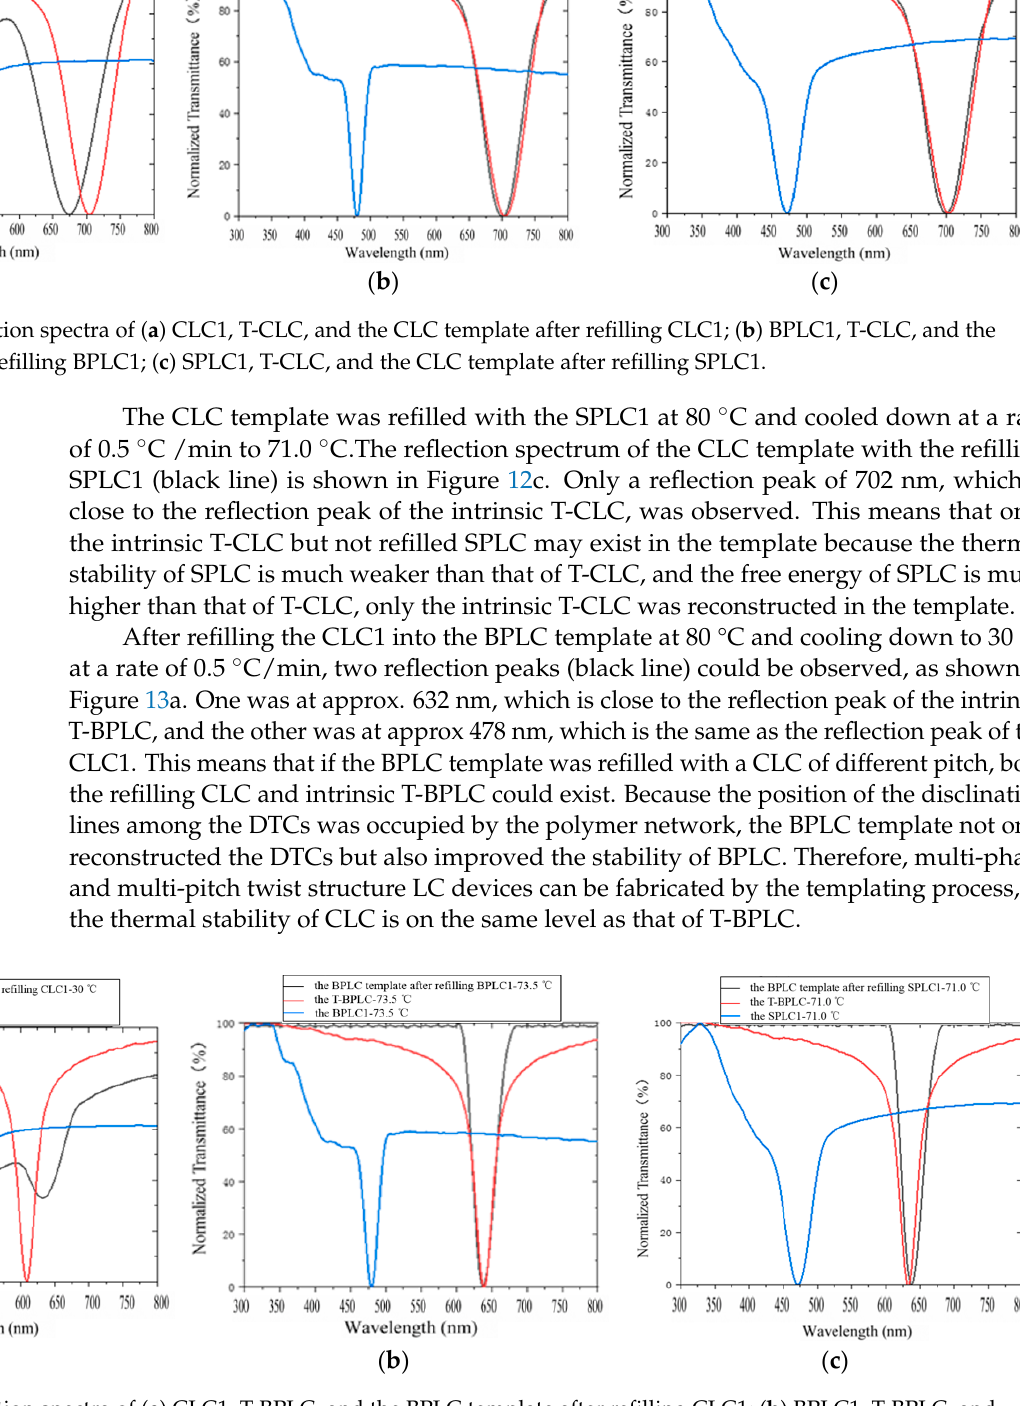
Figure 13. The reflection spectra of ( a ) CLC1, T-BPLC, and the BPLC template after refilling CLC1; ( b ) BPLC1, T-BPLC, and the BPLC template after refilling BPLC1; ( c ) SPLC1, T-BPLC, and the BPLC template after refilling SPLC1. The BPLC template was refilled with the BPLC1 at 80 °C and cooled down at a rate of 0.5 °C /min to 73.5 °C . The reflection spectrum of the BPLC template with the refilling BPLC1 (black line) is shown in Figure 13b. Only a reflection peak of 638 nm, which is the same as the reflection peak of the intrinsic T-BPLC, was observed. This means that only the intrinsic T-BPLC but not refilled BPLC may exist in the template because the thermal stability of BPLC is much weaker than that of T-BPLC, and the free energy of BPLC is much higher than that of T-BPLC; hence, only the intrinsic T-BPLC was reconstructed in the template. The BPLC template was refilled with the SPLC1 at 80 °C and cooled down at a rate of 0.5 °C/min to 71.0 °C. The reflection spectrum of the BPLC template with the refilling SPLC1 (black line) is shown in Figure 13 c . Only a reflection peak of 638 nm, which is close to the reflection peak of the intrinsic T-BPLC, was observed. This means that only the intrinsic T-BPLC but not refilled SPLC may exist in the template because the thermal stability of SPLC is much weaker than that of T-BPLC, and the free energy of SPLC is much higher than that of T-BPLC; hence, only the intrinsic T-BPLC was reconstructed in the template. After refilling the CLC2 into the SPLC template at 80 ℃ , and cooling down to 30 °C at a rate of 0.5 °C/min, the reflection spectrum of SPLC template with the refilling CLC2 (black line) was obtained, as shown in Figure 14a. Only a reflection peak of 470 nm was observed, which is close to the reflection peak of the intrinsic T-SPLC. This means that only the intrinsic T-SPLC but not refilled CLC may exist in the template. However, when the CLC2 was directly refilled into the SPLC template at 30 °C, two reflection peaks (black line) could be observed, as shown in Figure 14b. One was at approx. 468 nm, which is close to the reflection peak of the intrinsic T-SPLC, and another was at approx. 700 nm which is similar to the reflection peak of CLC2. This means that if a CLC of different pitch was directly refilled into the SPLC template at room temperature, both the refilling CLC and the intrinsic T-SPLC could co-exist.Therefore, multi-phase and multi-pitch twist structure LC devices can be fabricated. CLC was refilled into the SPLC template at 30 °C, and also refilled into the SPLC template in the isotropic phase, then cooled down to 30 °C. The measured reflection spectra showed different results. The reason is that although through the templating process, the thermal stability and free energy of T-SPLC are similar to those of CLC, compared to the CLC and BPLC templates, in addition to reconstructing the intrinsic T- SPLC, the SPLC template can also reconstruct the initial state of the refilling twist structure LC. For example, when a CLC was refilled into the SPLC template at room temperature, the SPLC template could reconstruct the original cholesteric phase of the refilling CLC. However when a CLC was refilled into the SPLC template in the isotropic phase and then was cooled down to 30 °C, the SPLC template could reconstruct the original isotropic state